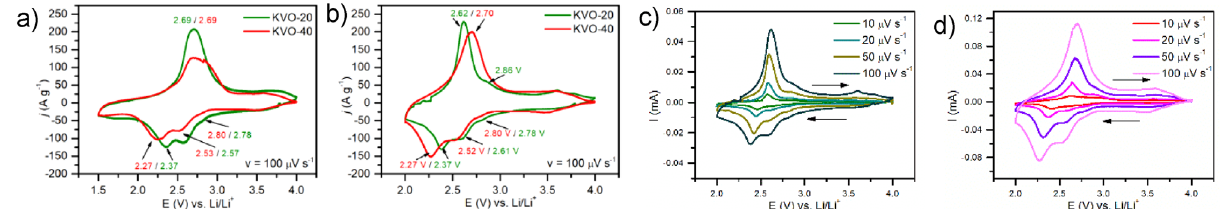
Figure 3. Cyclic voltammetry curves of KVO-20 and KVO-40 electrode materials at a scan rate of 100 µV s −1 over 1.5–4.0 V ( a ) and 2.0–4.0 V ( b ) potential window. Cyclic voltammetry curves at different scan rates for ( c ) KVO-20 and ( d )